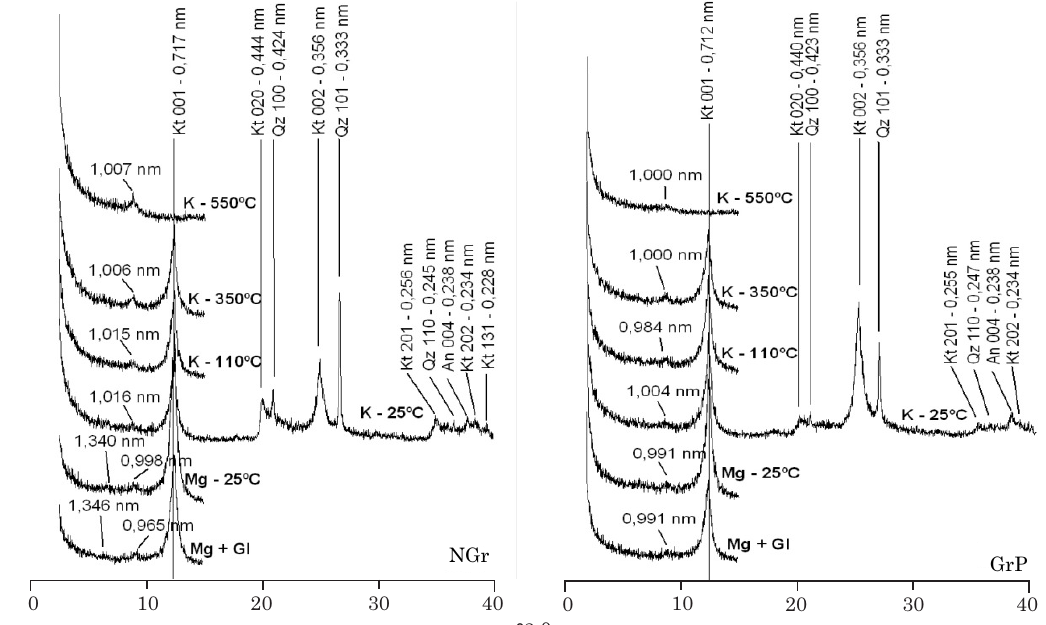
Figure 1. X-ray diffraction patterns of oriented iron-free clay fraction of a Rhodic Paleudult under natural grassland (NGr) and grazed native pasture with cattle droppings (GrP) after expansion and contraction treatments of 2:1 clay minerals. Kt: kaolinite; Qz: quartz; An: anatase. (K-C: K-saturated samples heated at different temperatures, Mg-25 o C: Mg-saturated samples at 25 o C, Mg+Gl: Mg-saturated and glycerol- solvated